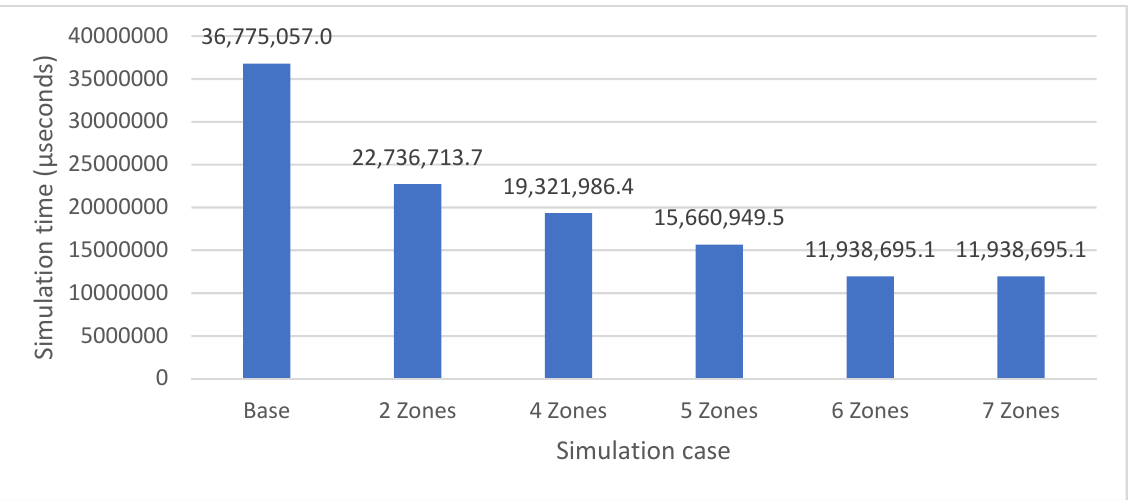
Figure 5. Simulation time required to solve a yearly simulation of Circuit 5.